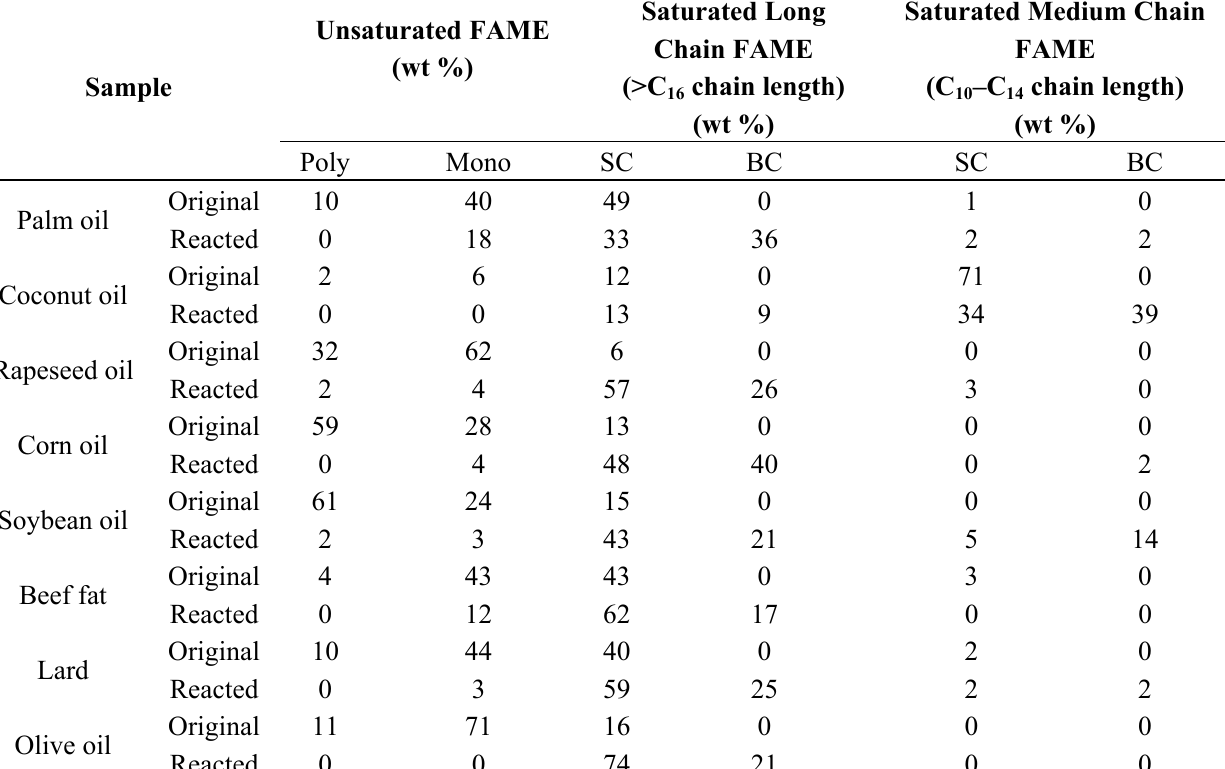
Table 2. GC/MS compositional analysis of reactant and product stream.